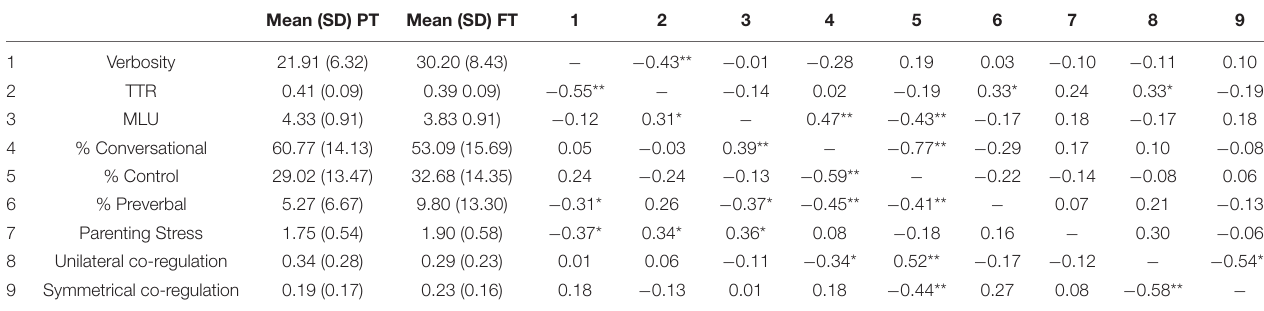
TABLE 2 | Descriptive and bivariate correlations in the preterm (above the diagonal, n = 42) and full-term (below the diagonal, n = 44)